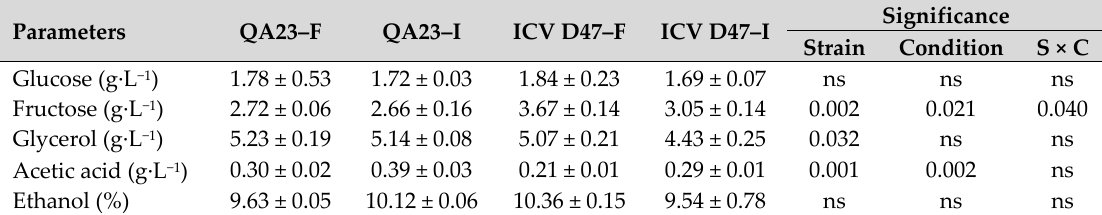
Table 2. Concentration of sugars, glycerol, acetic acid and ethanol (mean values and standard deviation) of mead fermented by S. cerevisiae QA23 and ICV D47 with free cells (F) or immobilized cells (I) and significance of the factors strain (S) and condition (C) according to two-way ANOVA.